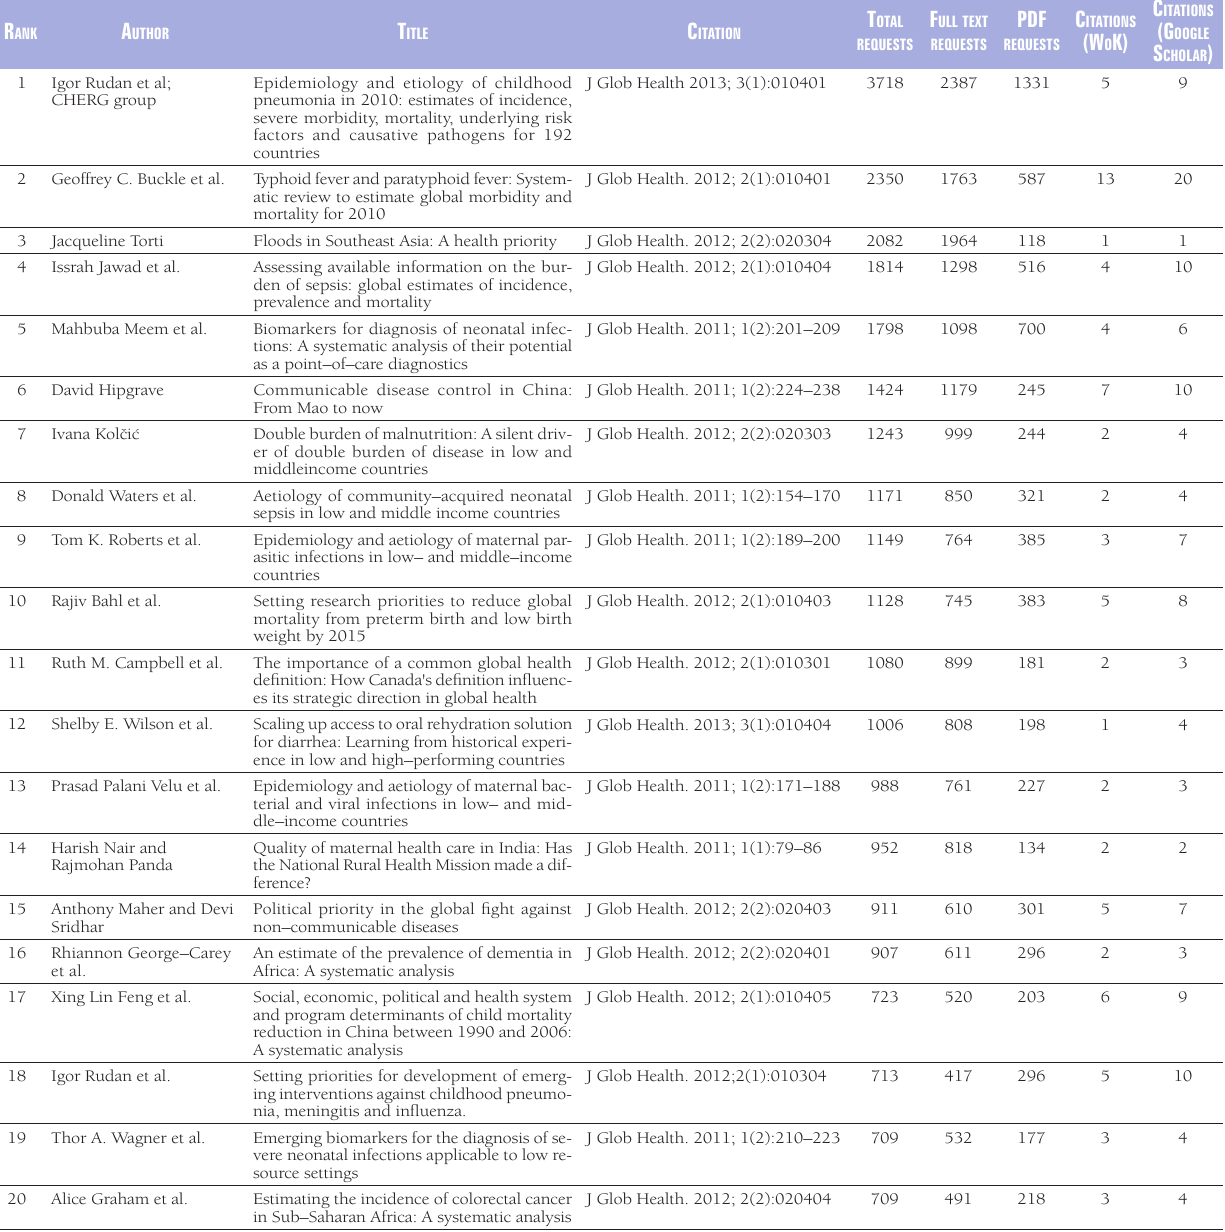
Table 1. Ranking the 20 most accessed papers published by the Journal of Global Health in the first 3 volumes (between June 2011 and December